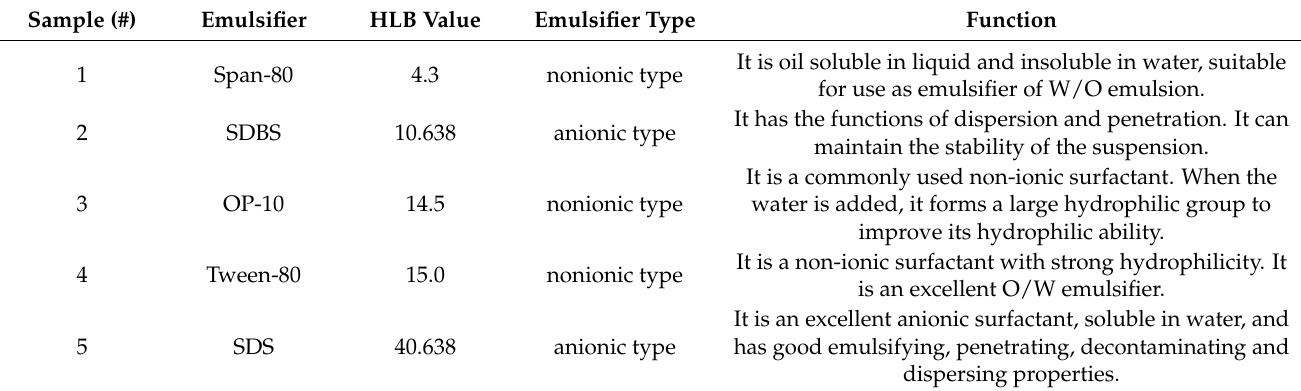
Table 3. Different emulsifier types and HLB